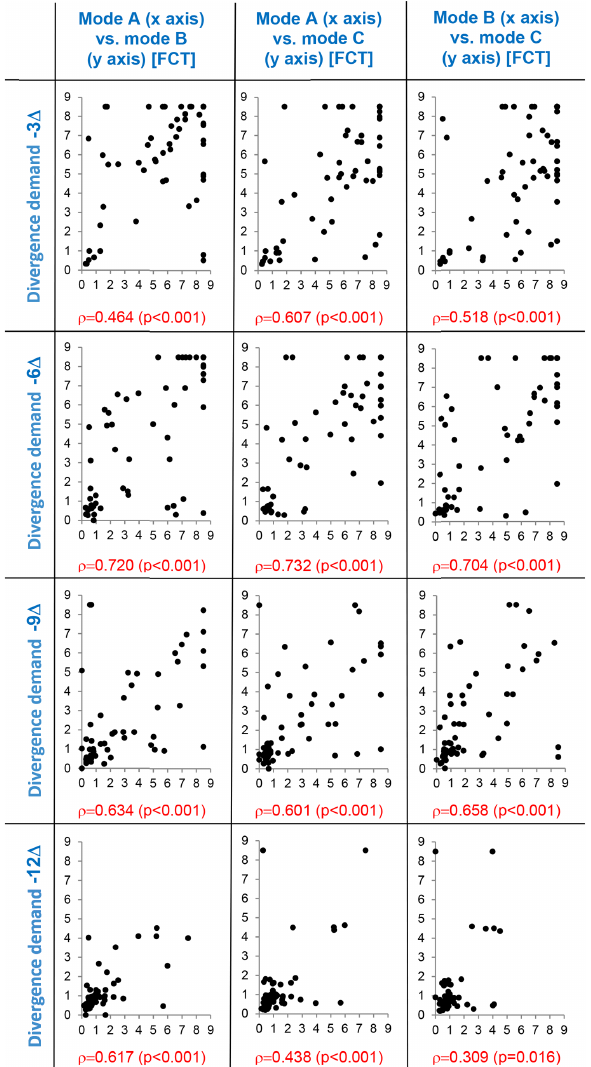
Figure 8. Correlation diagrams of suppressive threshold values between experimental degradation modes A, B, and C during convergence